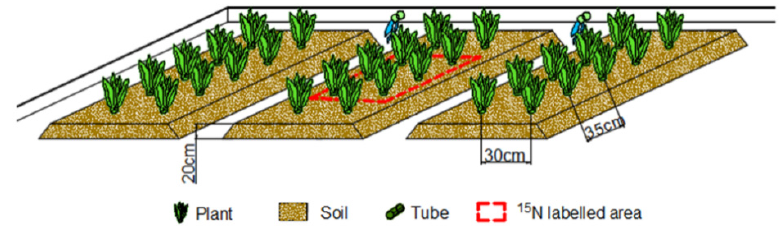
Figure 1. The experimental block and the layout of the micro area.